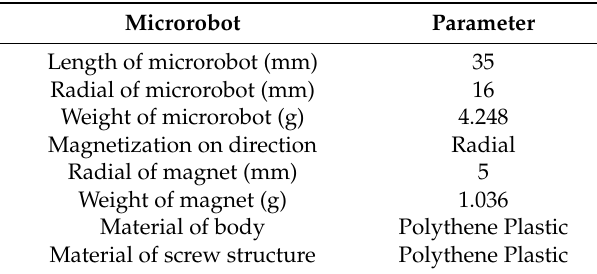
Figure 9. Magnetically actuated capsule microrobot with screw jet motion ( a ) Structure of the microrobot; ( b ) Prototype of the microrobot. Table 1. Specifications of the microrobot.